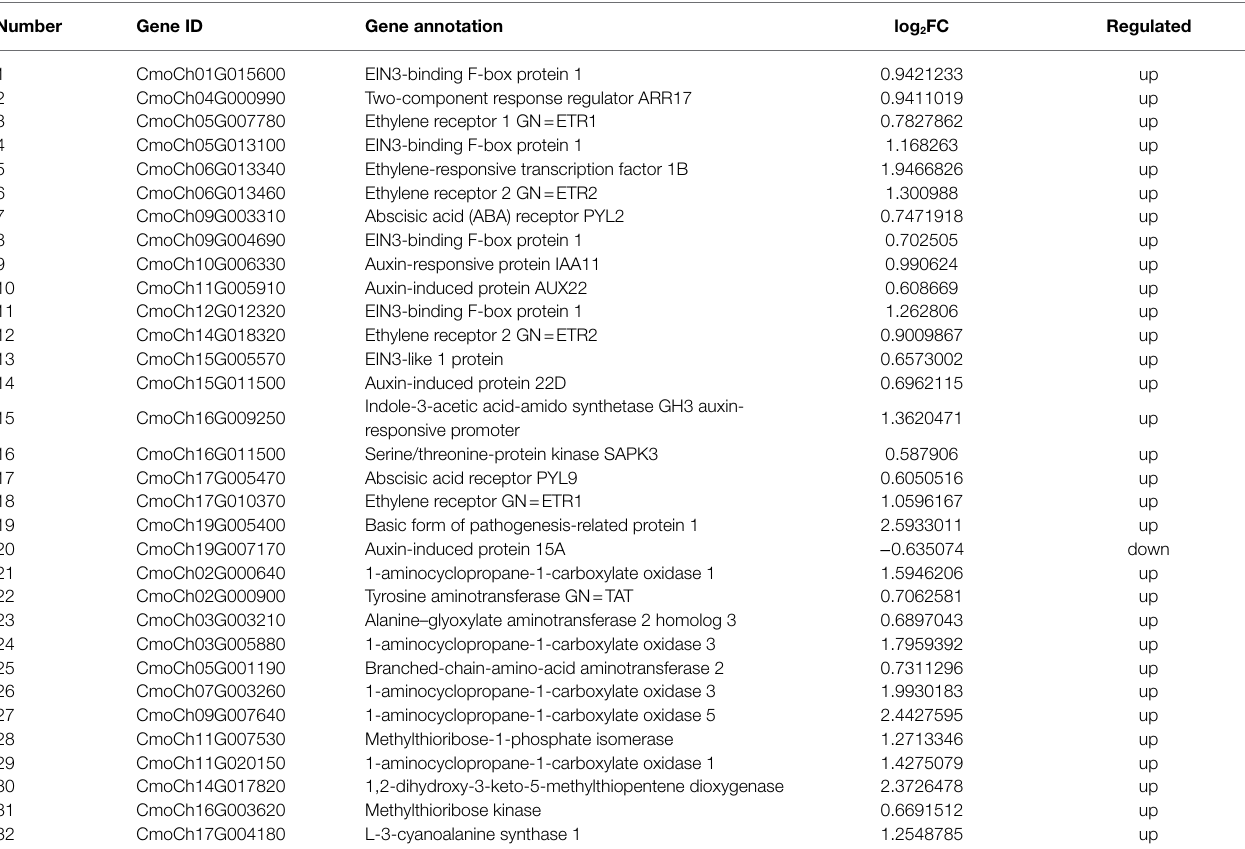
TABLE 2 | List of DEGs enriched in plant hormone signal transduction pathway (No. 1–20) and cysteine and methionine metabolism pathway (No. 21–32).